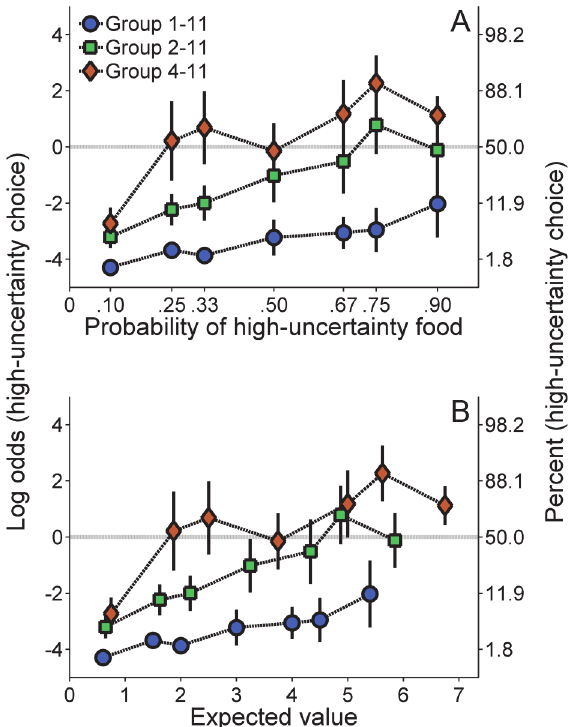
Fig 1. Mean ( ± SEM) log odds of high-uncertainty choices for each group in Experiment 1 as a function of the probability of high-uncertainty food delivery (A) and the expected value of the high-uncertainty outcome (B). The horizontal line indicates neutral preference of the two outcomes. Values below this line reflect risk aversion (more low-uncertainty than high-uncertainty choices), and values above it reflect risk proneness (more high-uncertainty than low-uncertainty choices). A second ordinate showing the percentages corresponding to the log odds values was included to aid interpretation.